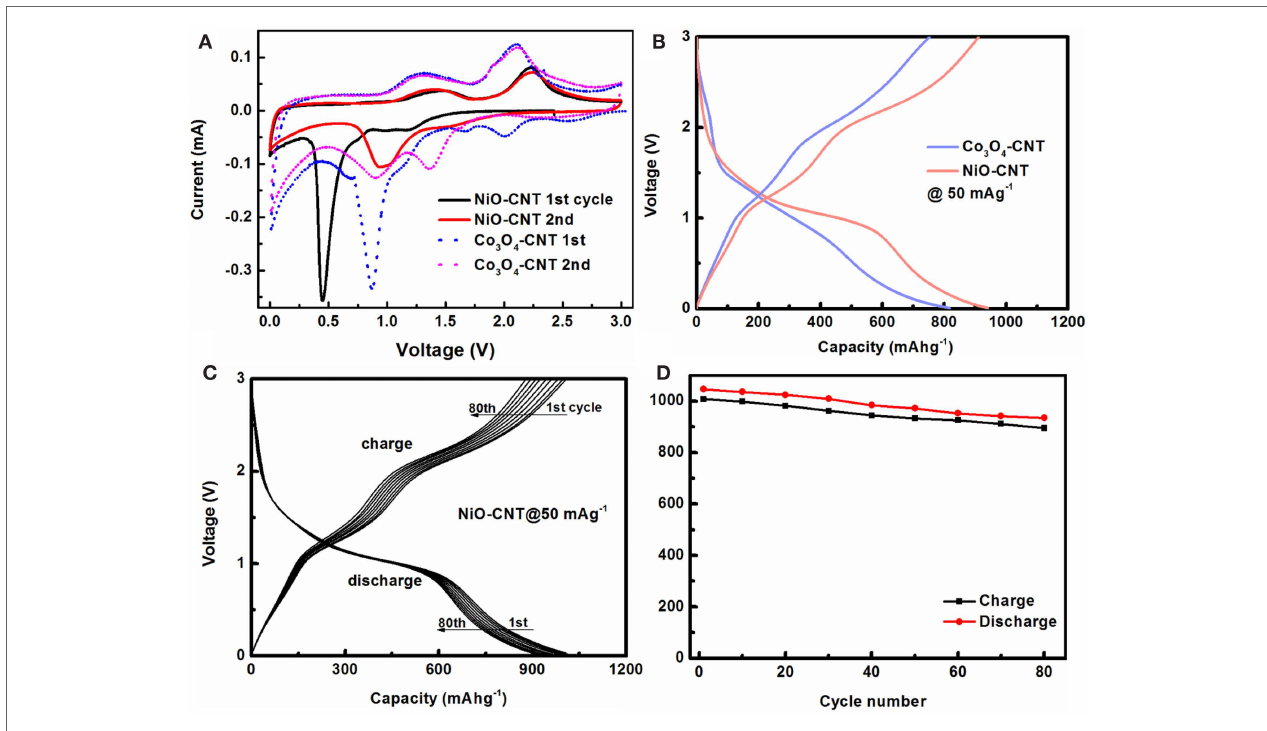
O /SWNT and NiO/SWNT. 3 4